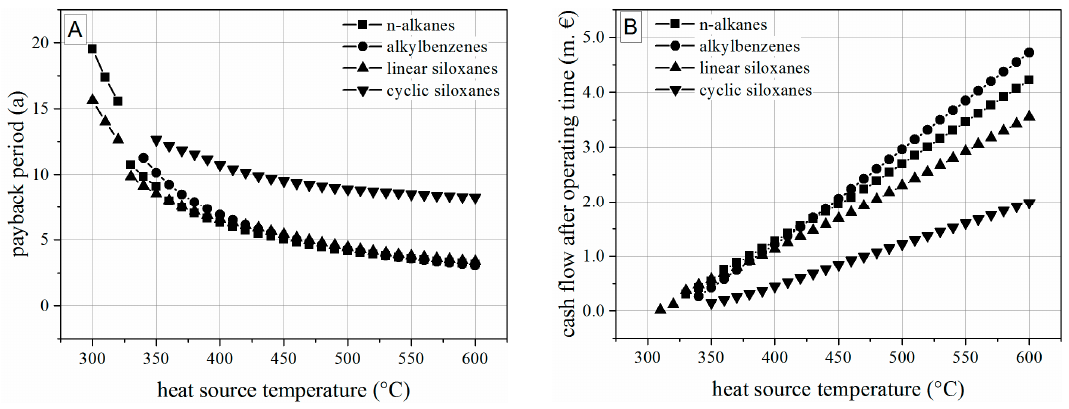
Figure 8. Payback period ( A ) in years and cash flow ( B ) in million € for all four chemical classes depending on heat source temperature.